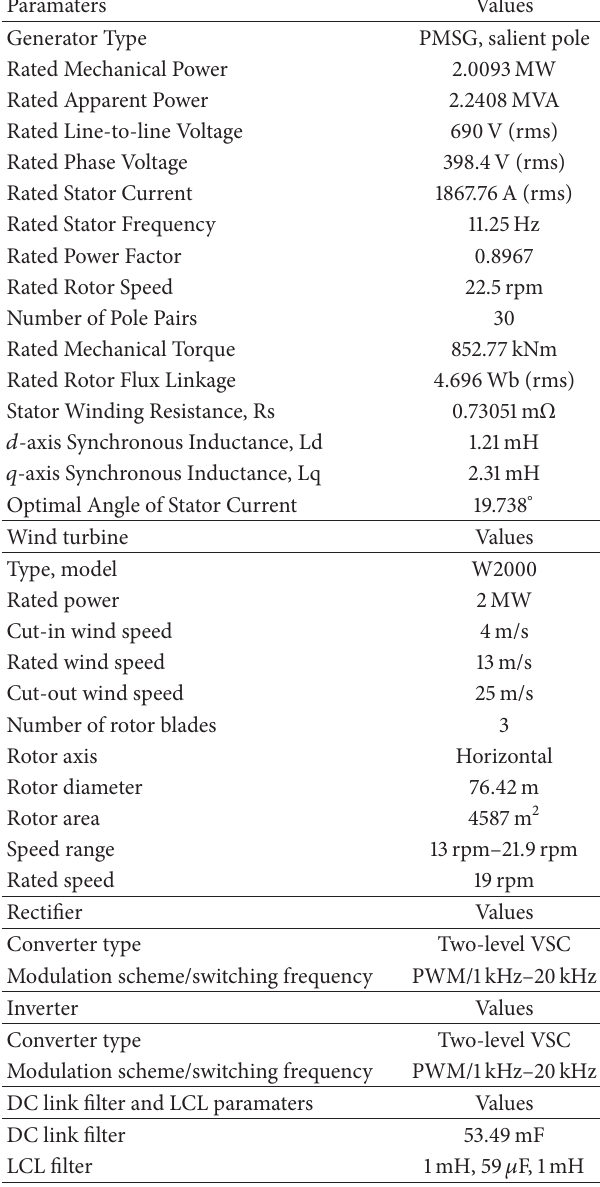
Table 1: THD rates of IGBT-PWM power converter according to switching frequency values.